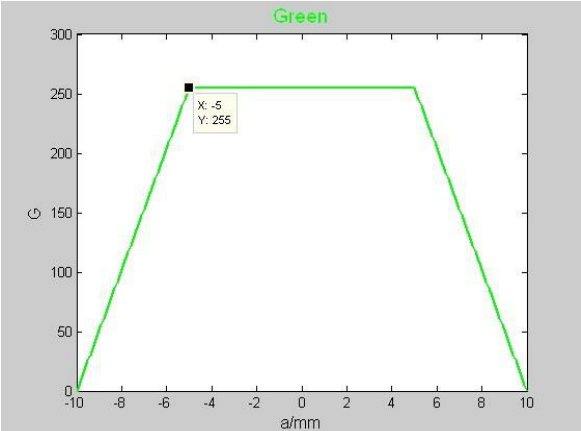
Figure 4. Green colour coding when the deformation velocity ranges from -10mm/y to 10mm/y